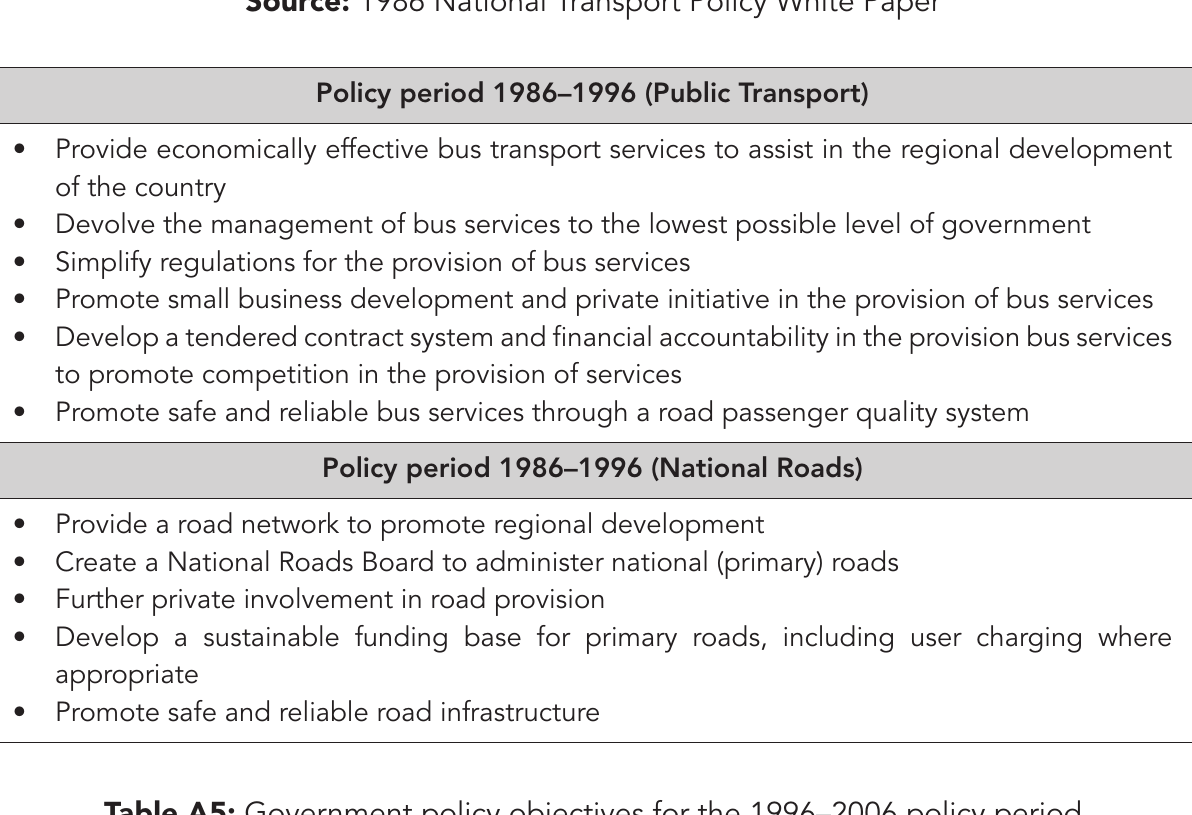
Table A4: Government Policy Objectives for the 1986–1996 policy period